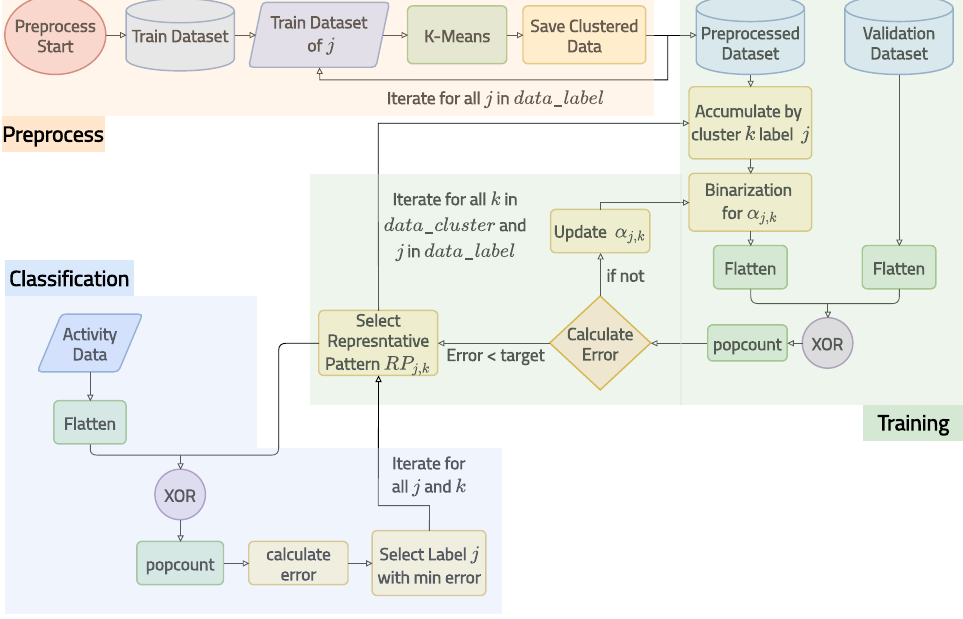
Figure 6. Overall strucutre of the proposed algorithm.